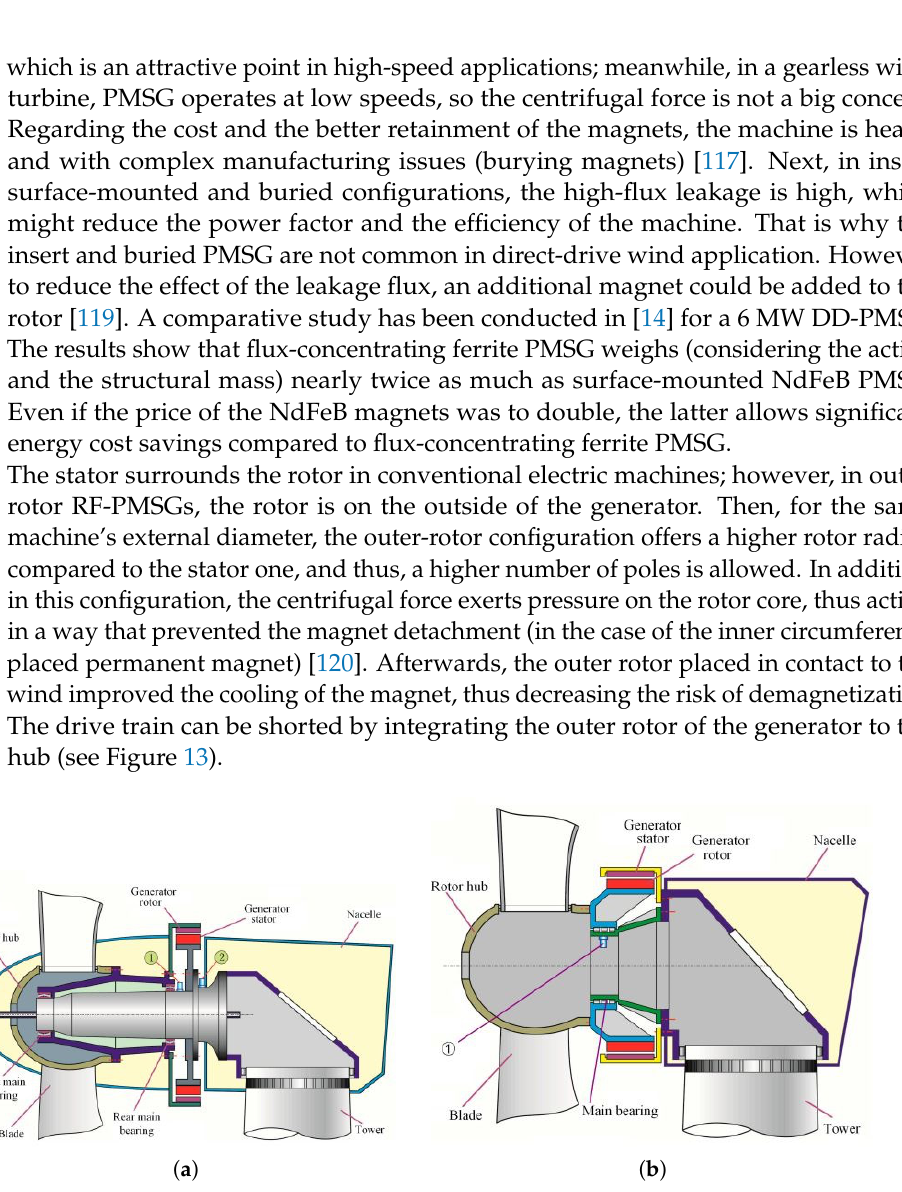
Figure 13. Comparison of wind turbine rotor concepts [121]. ( a ) External rotor. ( b ) Internal